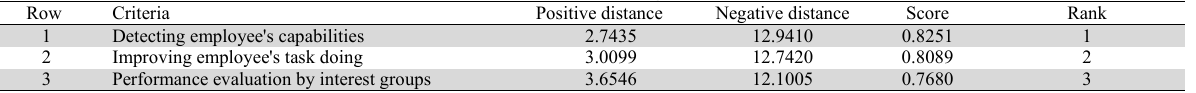
The results of Performance evaluation sub-criteria ranking